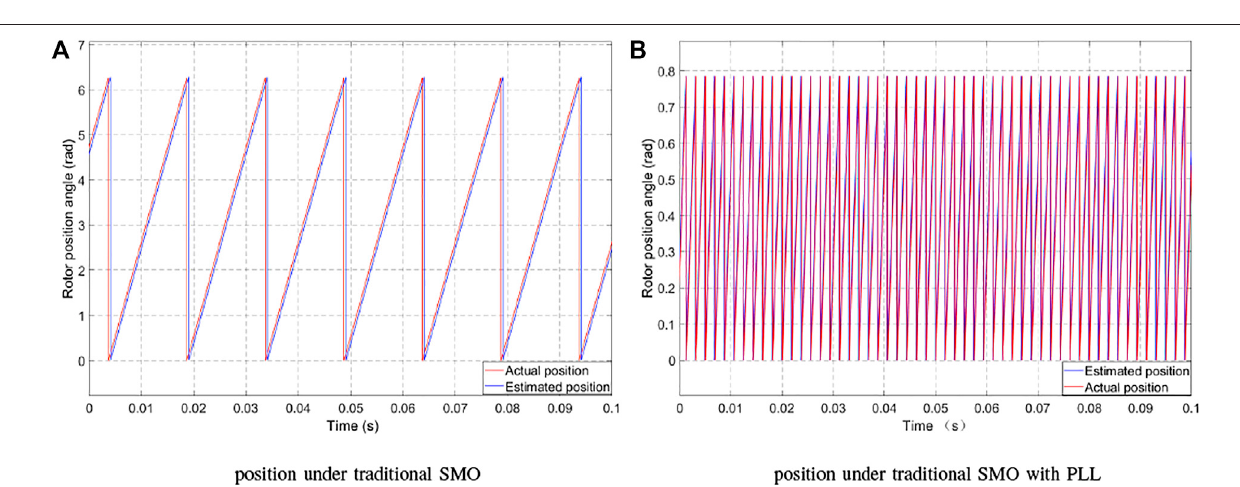
Frontiers in Energy Research |